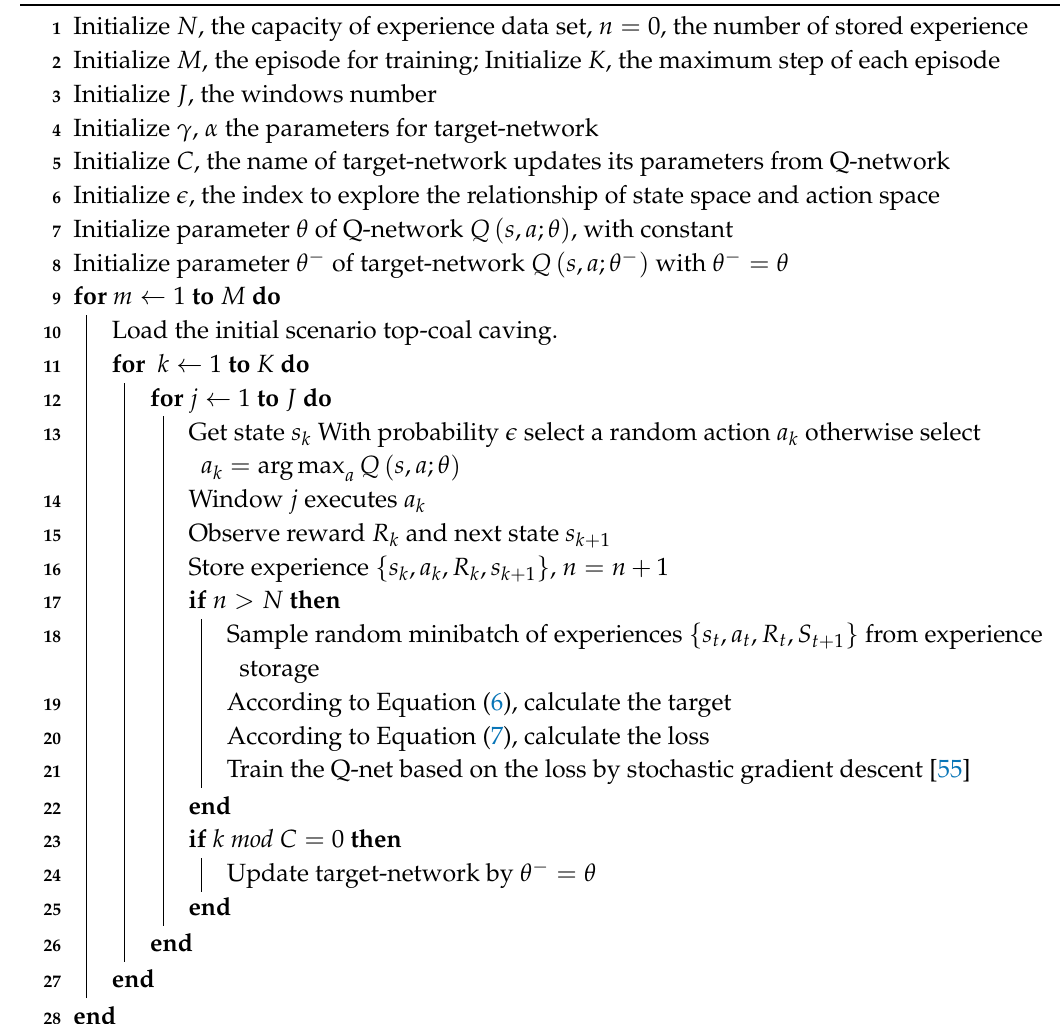
Algorithm 1: DQN for top-coal